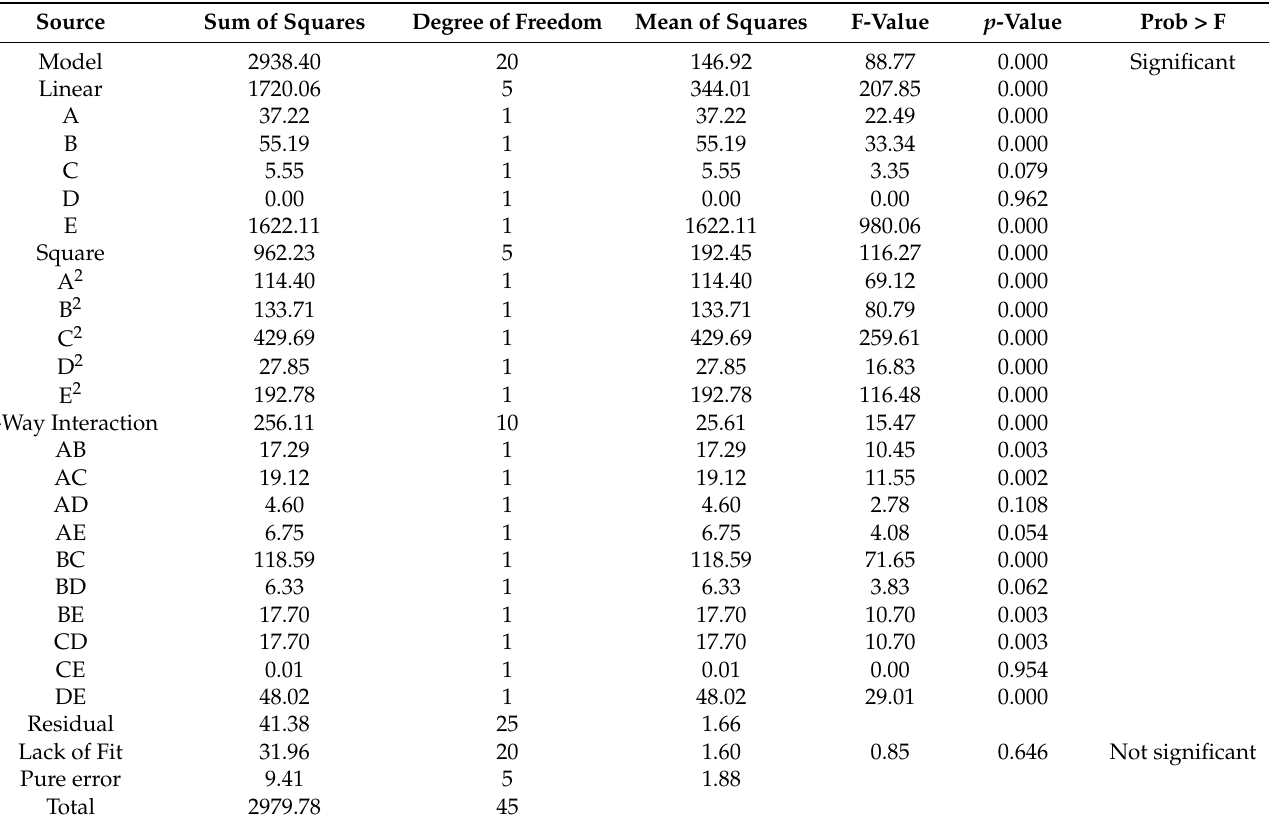
Table 7. ANOVA for the experimental results of pectinase biosynthesis by M. hiemalis